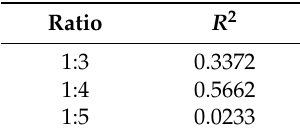
Table 2. Fitting correlation coefficients of the Lagergren pseudo-first-order kinetic model.